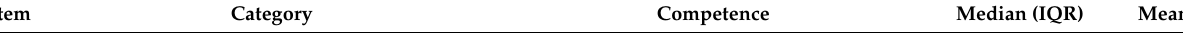
Table 2. Overview of all items asked in the individual categories in the field of anesthesiology (general anesthesia, regional anesthesia and pain therapy) and the average rating of the participants from 1 (“not relevant at all”) to 6 (“very relevant”) as median and IQR and mean value and SD.